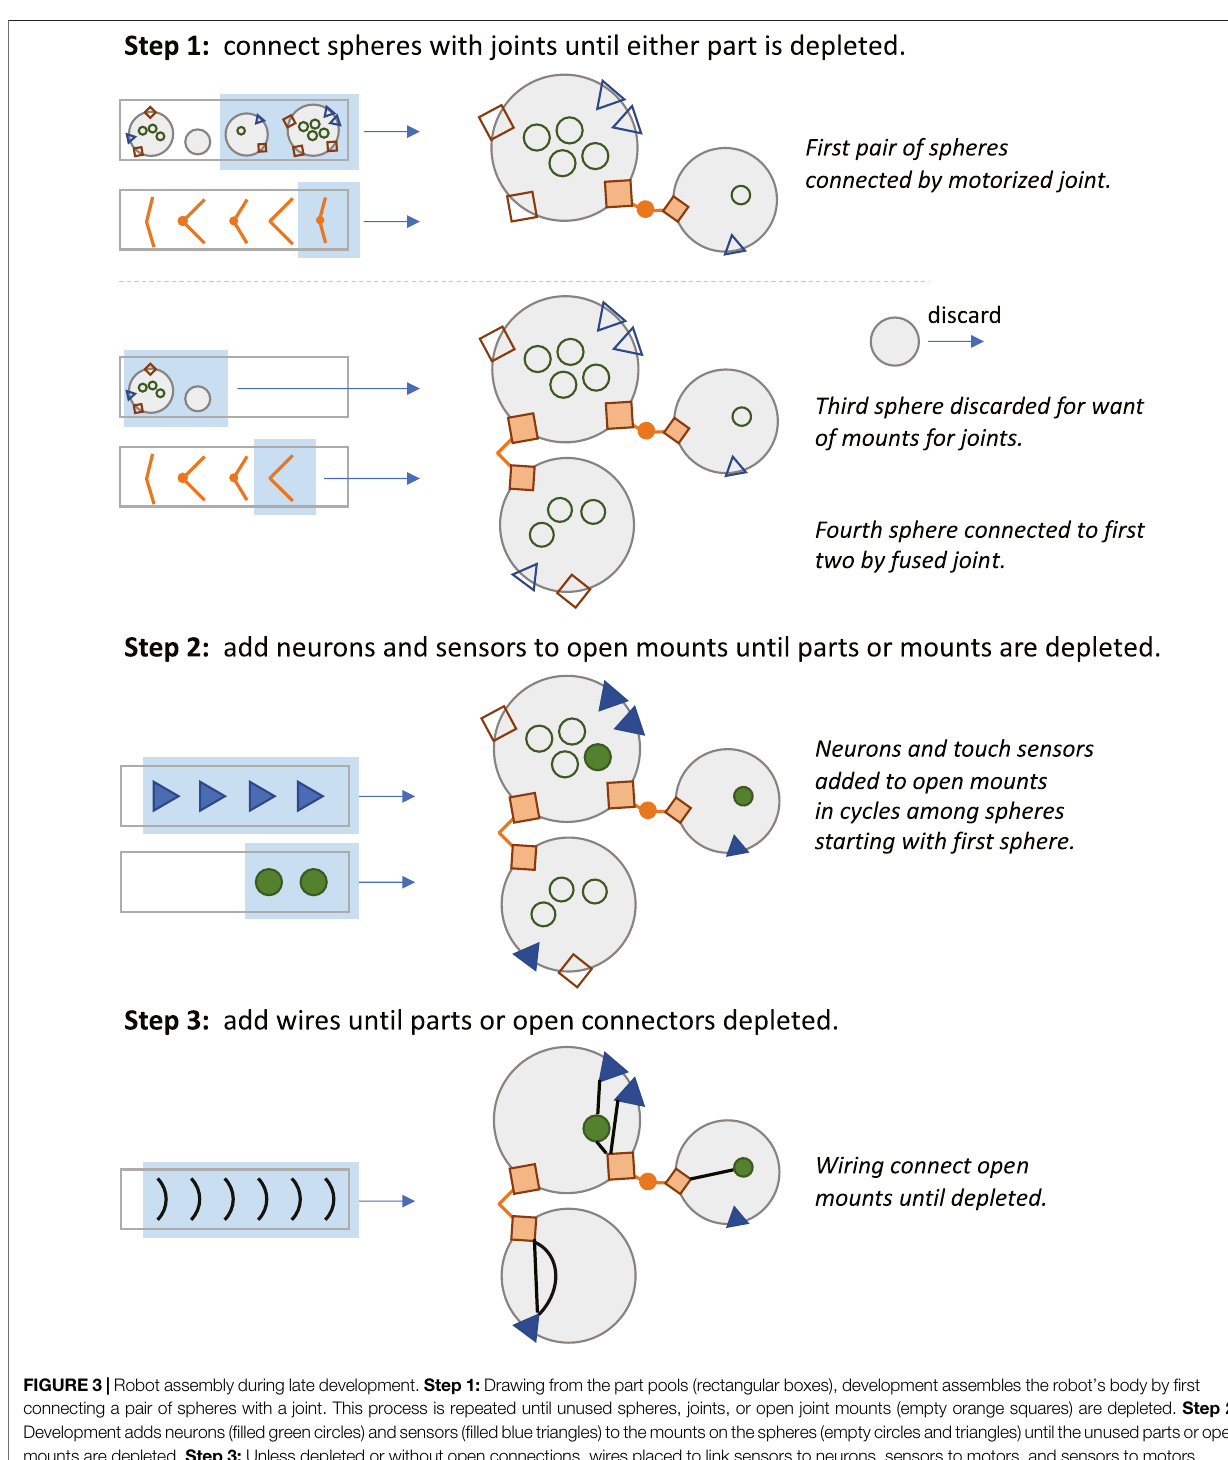
Frontiers in Robotics and AI |